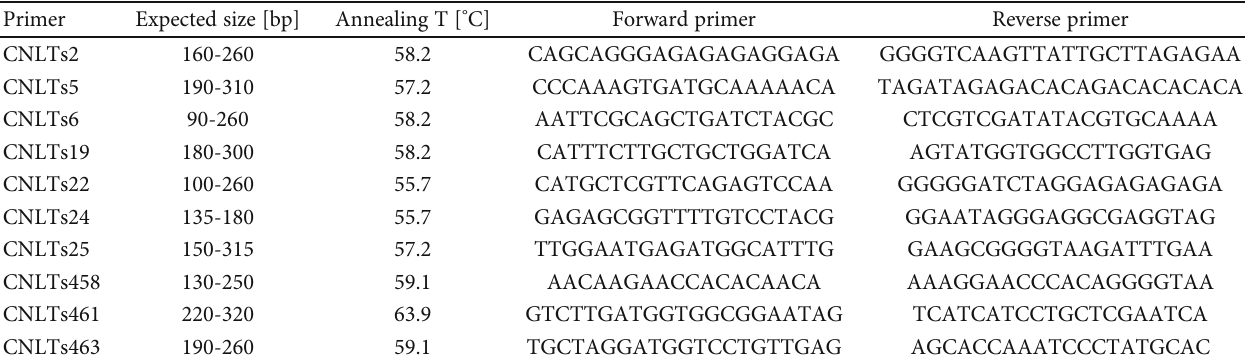
Table 2: Locus name, expected size, annealing temperature, and sequence of the 10 selected microsatellite